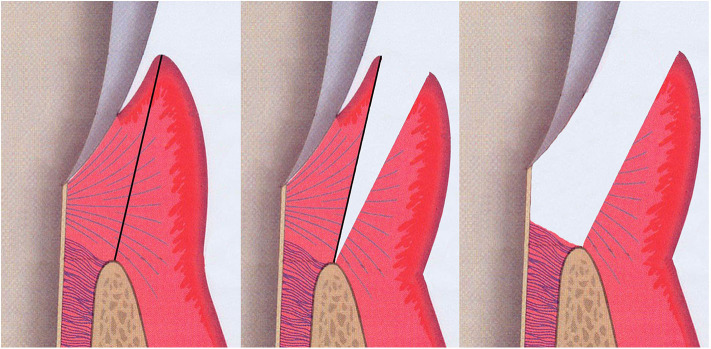
Illustration of the sample sits for gingival tissue. Both pocket epithelium and underlying connective tissue were included in the gingival specimen taken from the approximal sites of the selected teeth (grey; tooth, pink; gingival connective tissue, purple-red; gingival epithelium, brown-beige; alveolar bone).